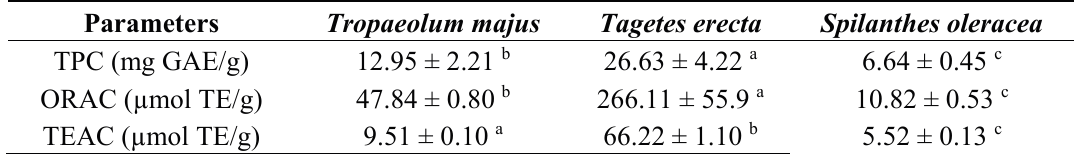
Table 3. Folin total phenolic compounds (TPC), oxygen radical absorbance capacity (ORAC) and Trolox equivalent antioxidant capacity (TEAC) in edible flowers 1 .